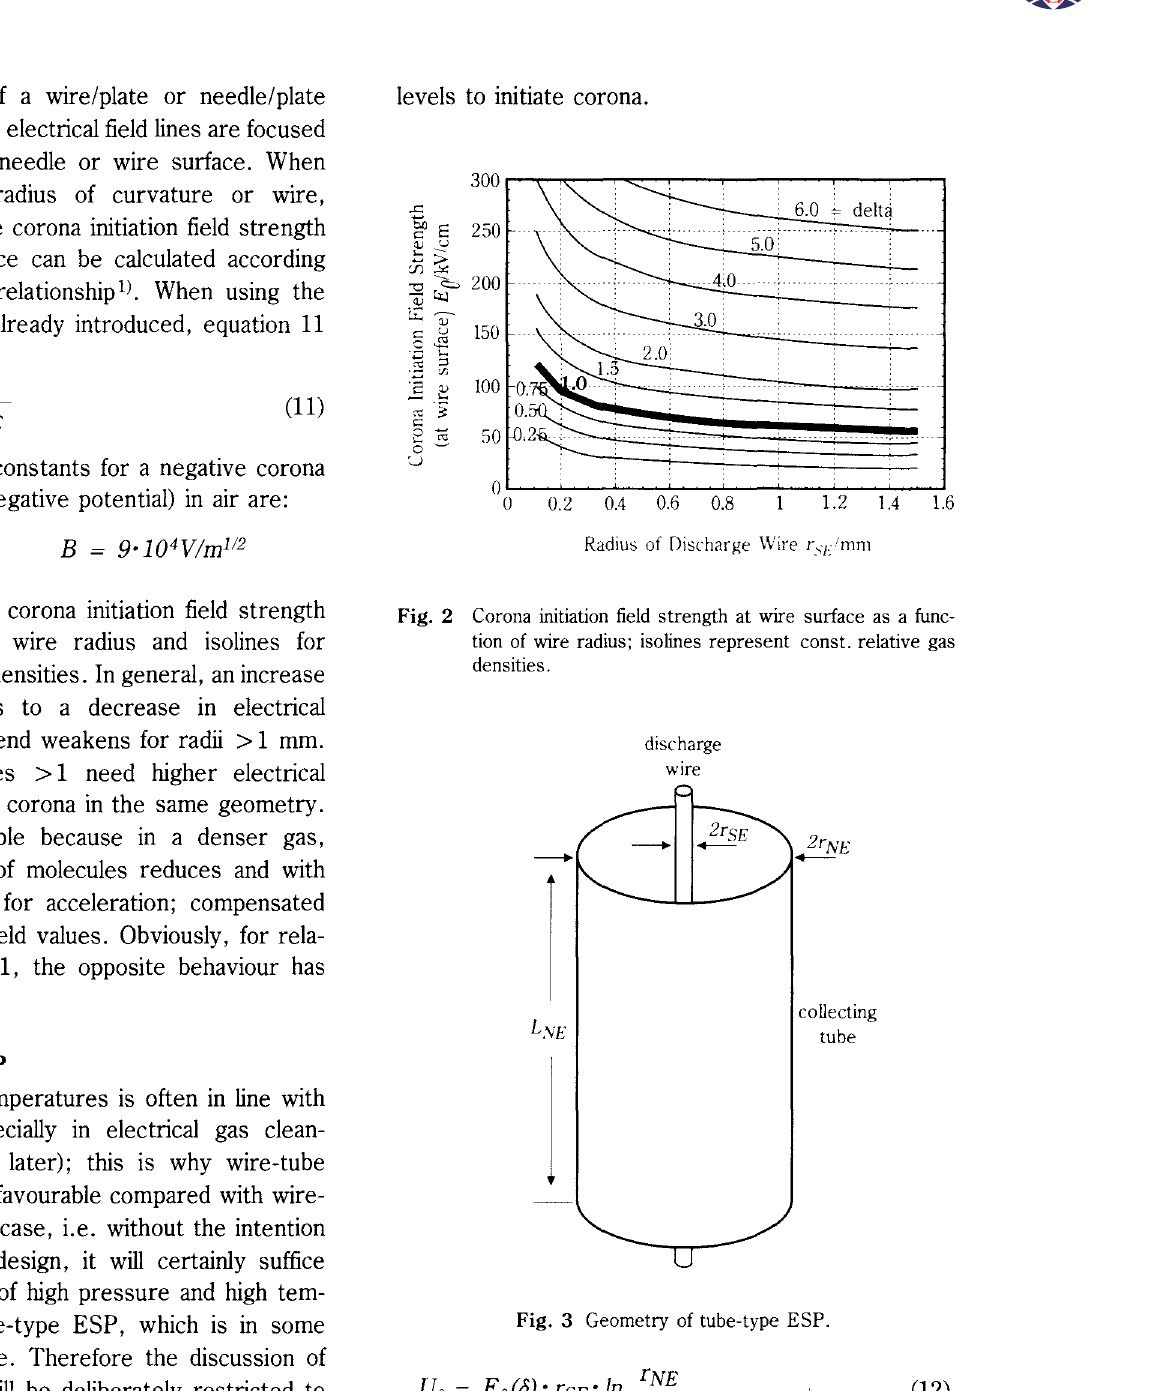
Fig. 3 Geometry of tube-type